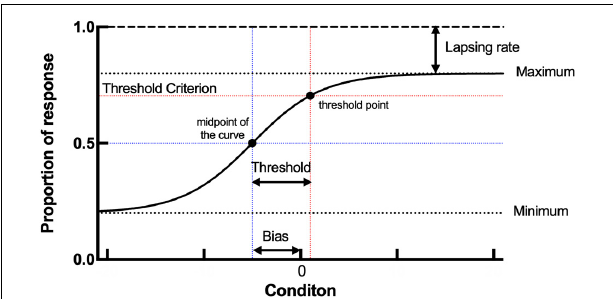
FIGURE 3 | Example plots of a young participant and an old participant showing the raw data analysis in the orientation task. ( A,B , respectively) Examples of the staircase plots showing the within-staircase trail number versus the orientation angles in Gabor patches for a young participant and an old participant. Open symbols are for convergence point of 28.57% and filled symbols for convergence points of 71.43%. The negative angles represent counterclockwise relative to the vertical, and vice versa . (C) Examples of the plots showing the proportion of the clockwise responses versus the orientation angles in Gabor patches and the respective psychometric functions. The black X shape, rhombus, and curve (function parameters: l = 0.0072, µ = 1.5518, and σ = 2.4718) for an old participant. The blue dots, rhombus, and curve for a young participant (function parameters: l = 0.0028, µ = 0.0782, and σ = 0.9106). Rhombus is the midpoint of the curve.